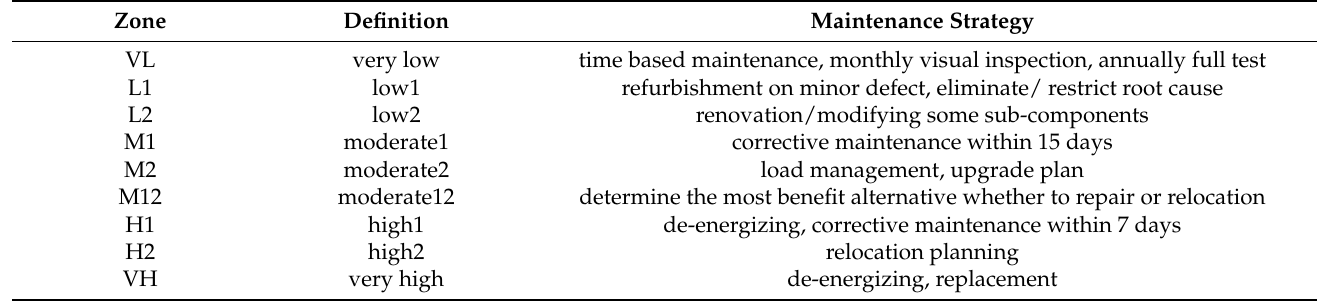
Table 6. Failure probability zone and recommended maintenance action in the risk matrix.